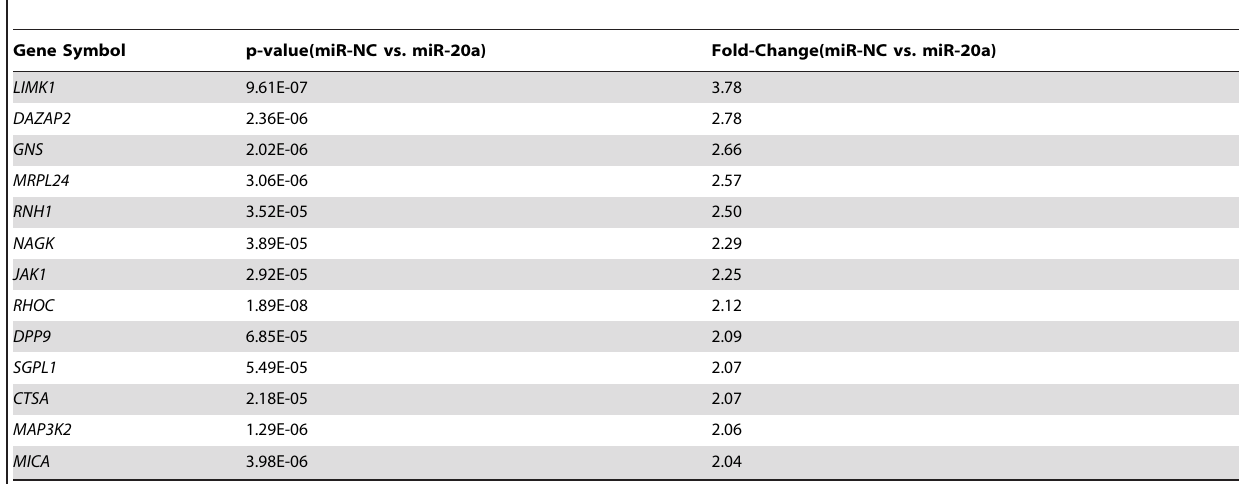
Table 1. Genes identified to be regulated by miR-20a using both microarray analysis and target scan analysis.*